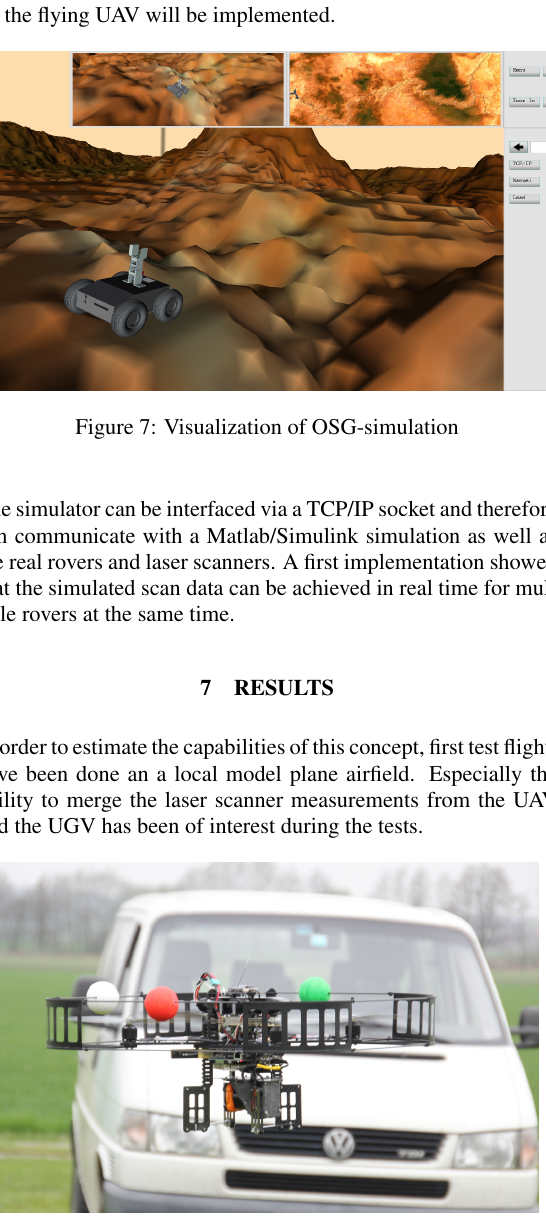
Figure 8: Picture of UAV in front of the test